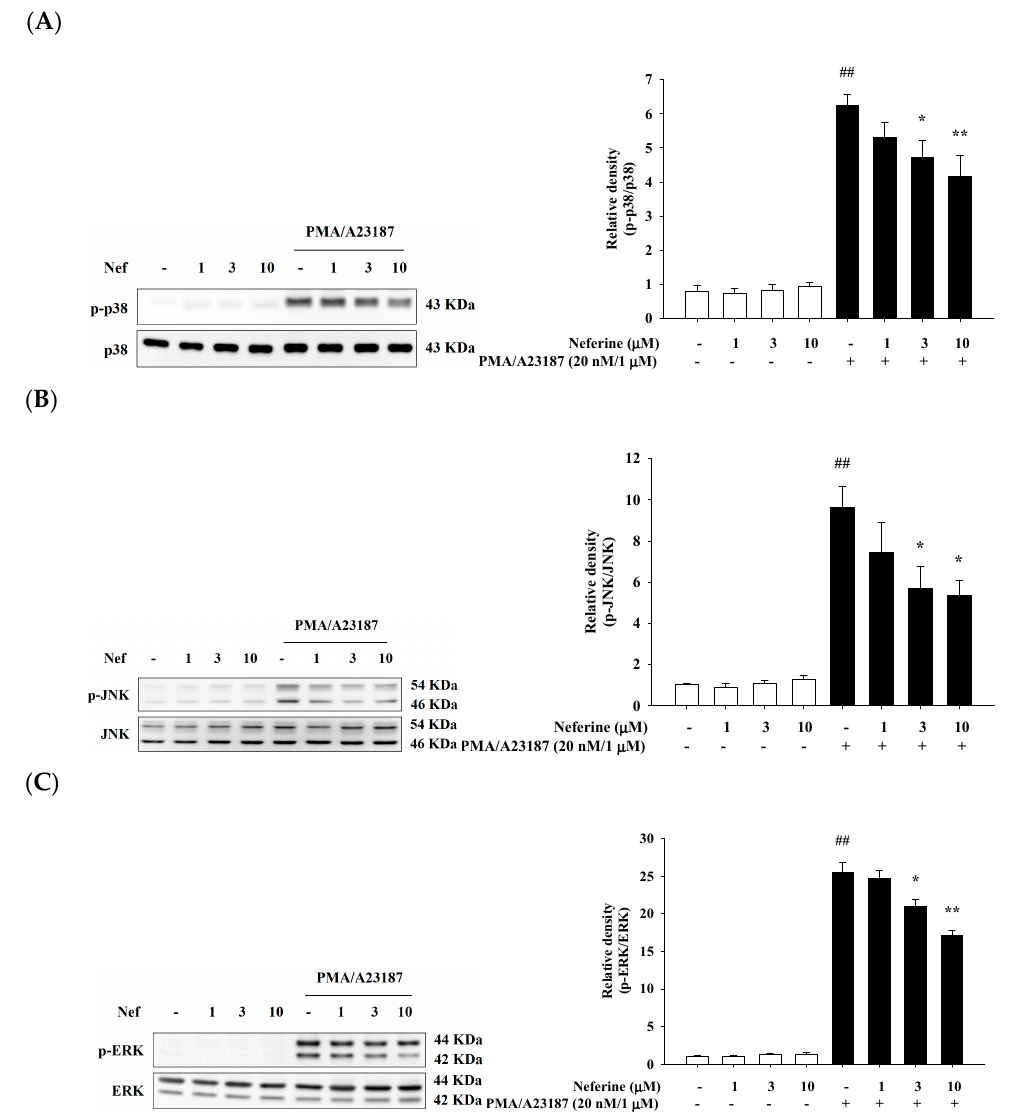
Figure 5. Neferine reduced PMA/A23187-induced JNK ( A ), p38 ( B ), and ERK ( C ) activation in RBL-2H3 cells. RBL-2H3 cells were pretreated with different concentrations of neferine—1, 3, and 10 μ M—for 20 min, and then the cells were treated with PMA/A23187 (20 nM/1 μ M) for 30 min. Western blots were analyzed quantitatively. Values represent the mean ± SEM from the three independent experiments. ## p < 0.01 compared with the no-treatment condition, * p < 0.05, ** p < 0.01 compared with the only PMA/A23187 treatment condition.